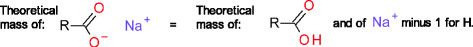
The process of calculation of the final theoretical mass of the substances. Normally, the molecule form is hydrogenated by the system, but the final mass is calculated correctly by the sum of the values of the acid and counter ion minus one hydrogen.